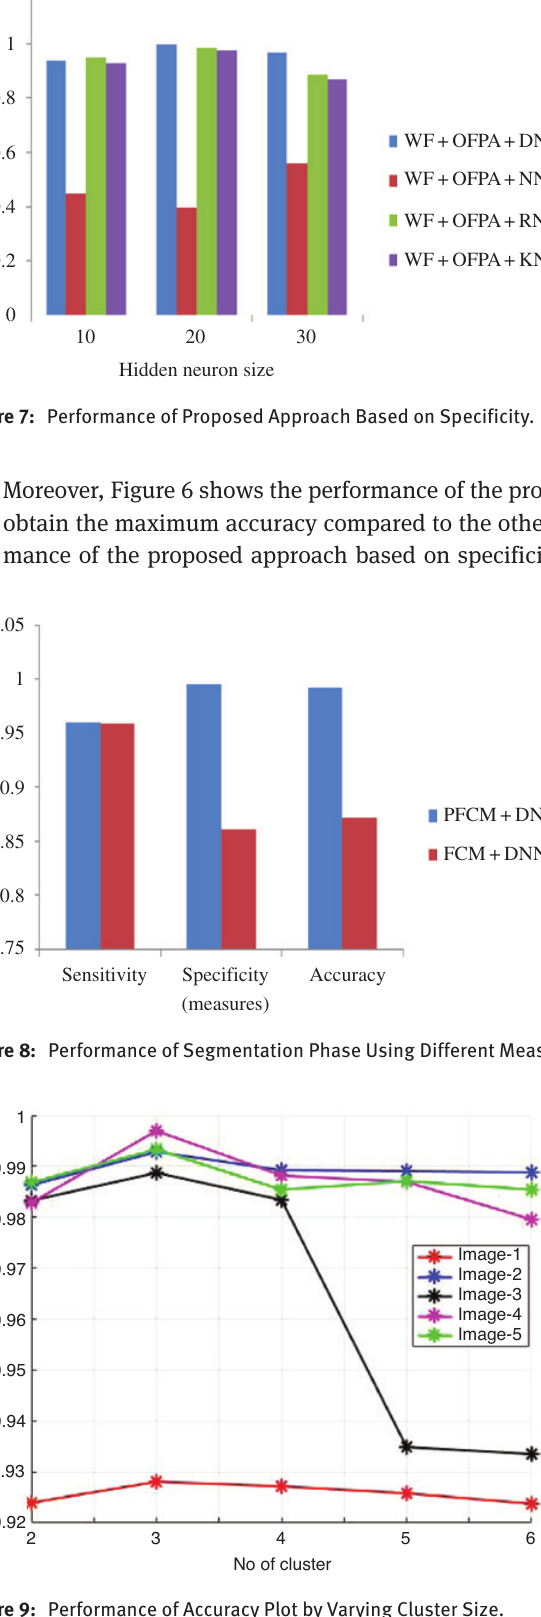
Figure 9: Performance of Accuracy Plot by Varying Cluster